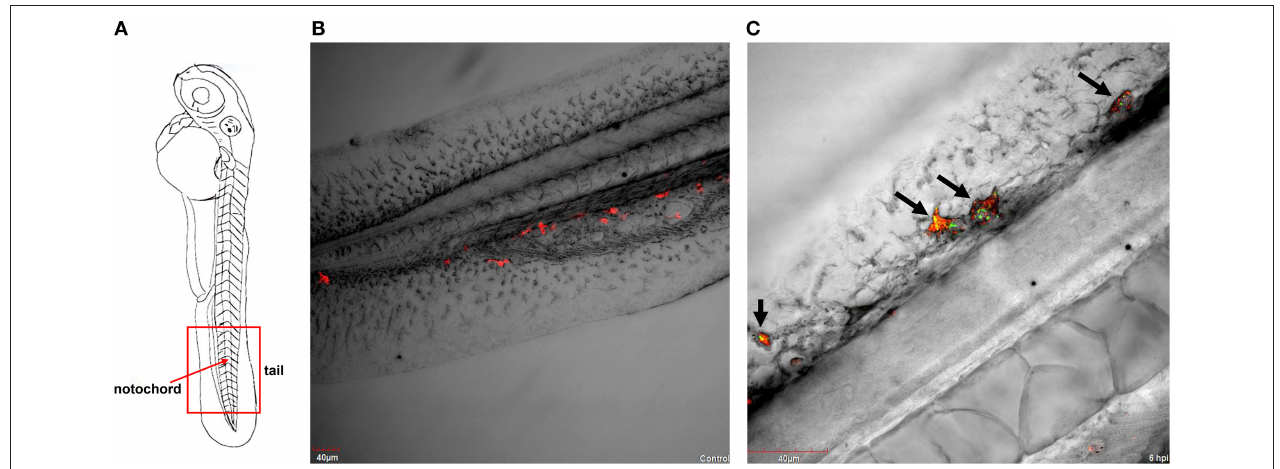
FIGURE 1 | P. aeruginosa PASS1-macrophage interaction in zebrafish at 6 hpi. (A) A schematic view of a zebrafish embryo. The red box represents the tail region, and the red arrow indicates vertebrate notochord. Confocal laser scanning microscopy of transgenic embryos of Danio rerio Tg ( mpeg1:Gal4, UAS;mCherry-CAAX ) injected into the duct of Cuvier with (B) phosphate buffered saline and with (C) YFP-labelled P. aeruginosa PASS1 at 48 hpf. (B) Post-infection with phosphate buffered saline, macrophages are localized in the tail region of the vertebrate. (C) The black arrows on the vertebrate notochord in the tail region of zebrafish embryos indicate either an association or engulfment of P. aeruginosa PASS1-YFP cells (in green) by macrophages (in red).